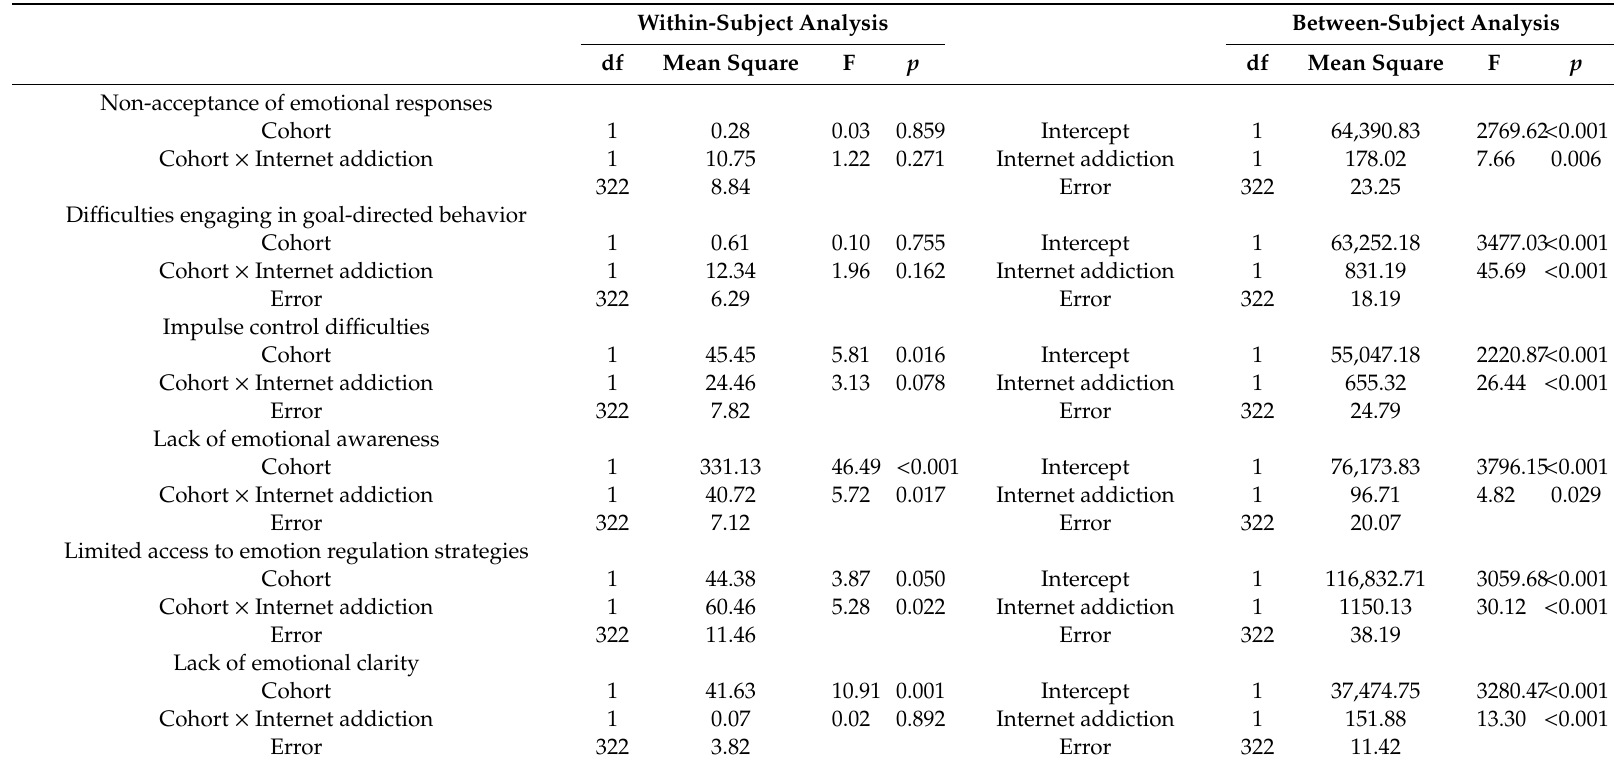
Table 3. Interactions between Internet addiction and changes in di ffi culty in emotion regulation analyzed by repeated-measures